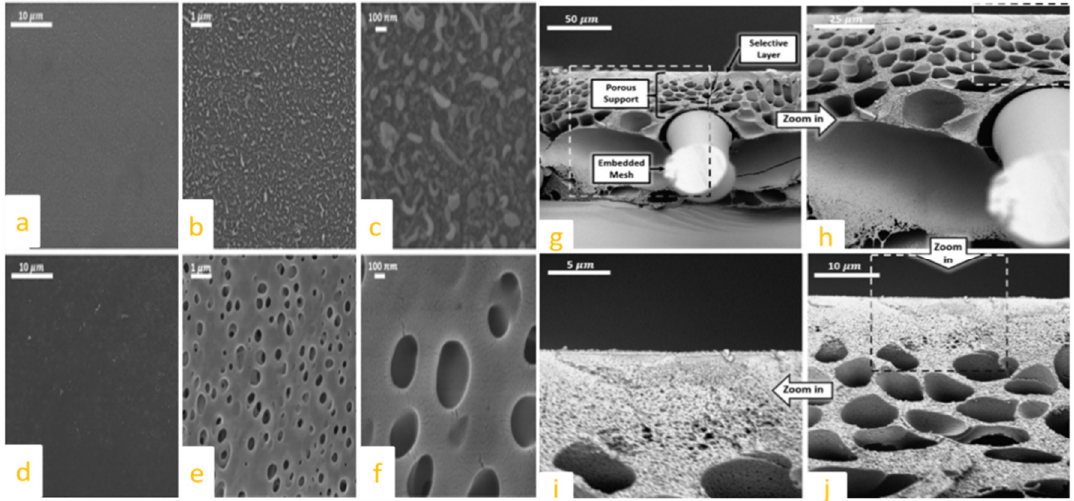
Figure 7. SEM images for top surface ( a – c ); SEM images for bottom surface ( d – f ), and Cross–sectional SEM images ( g – j ) of TFC membrane at different magnifications with dotted boxes showing the zoomed sections. Reprinted figure with permission from [74]. Copyright (2014) Elsevier.